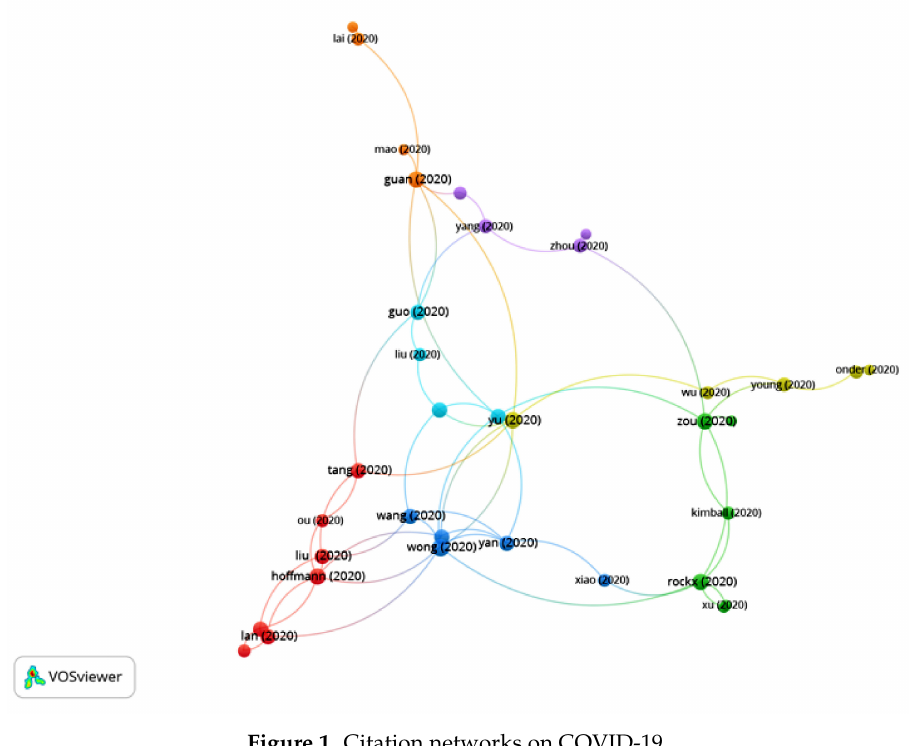
Figure 1. Citation networks on COVID-19.